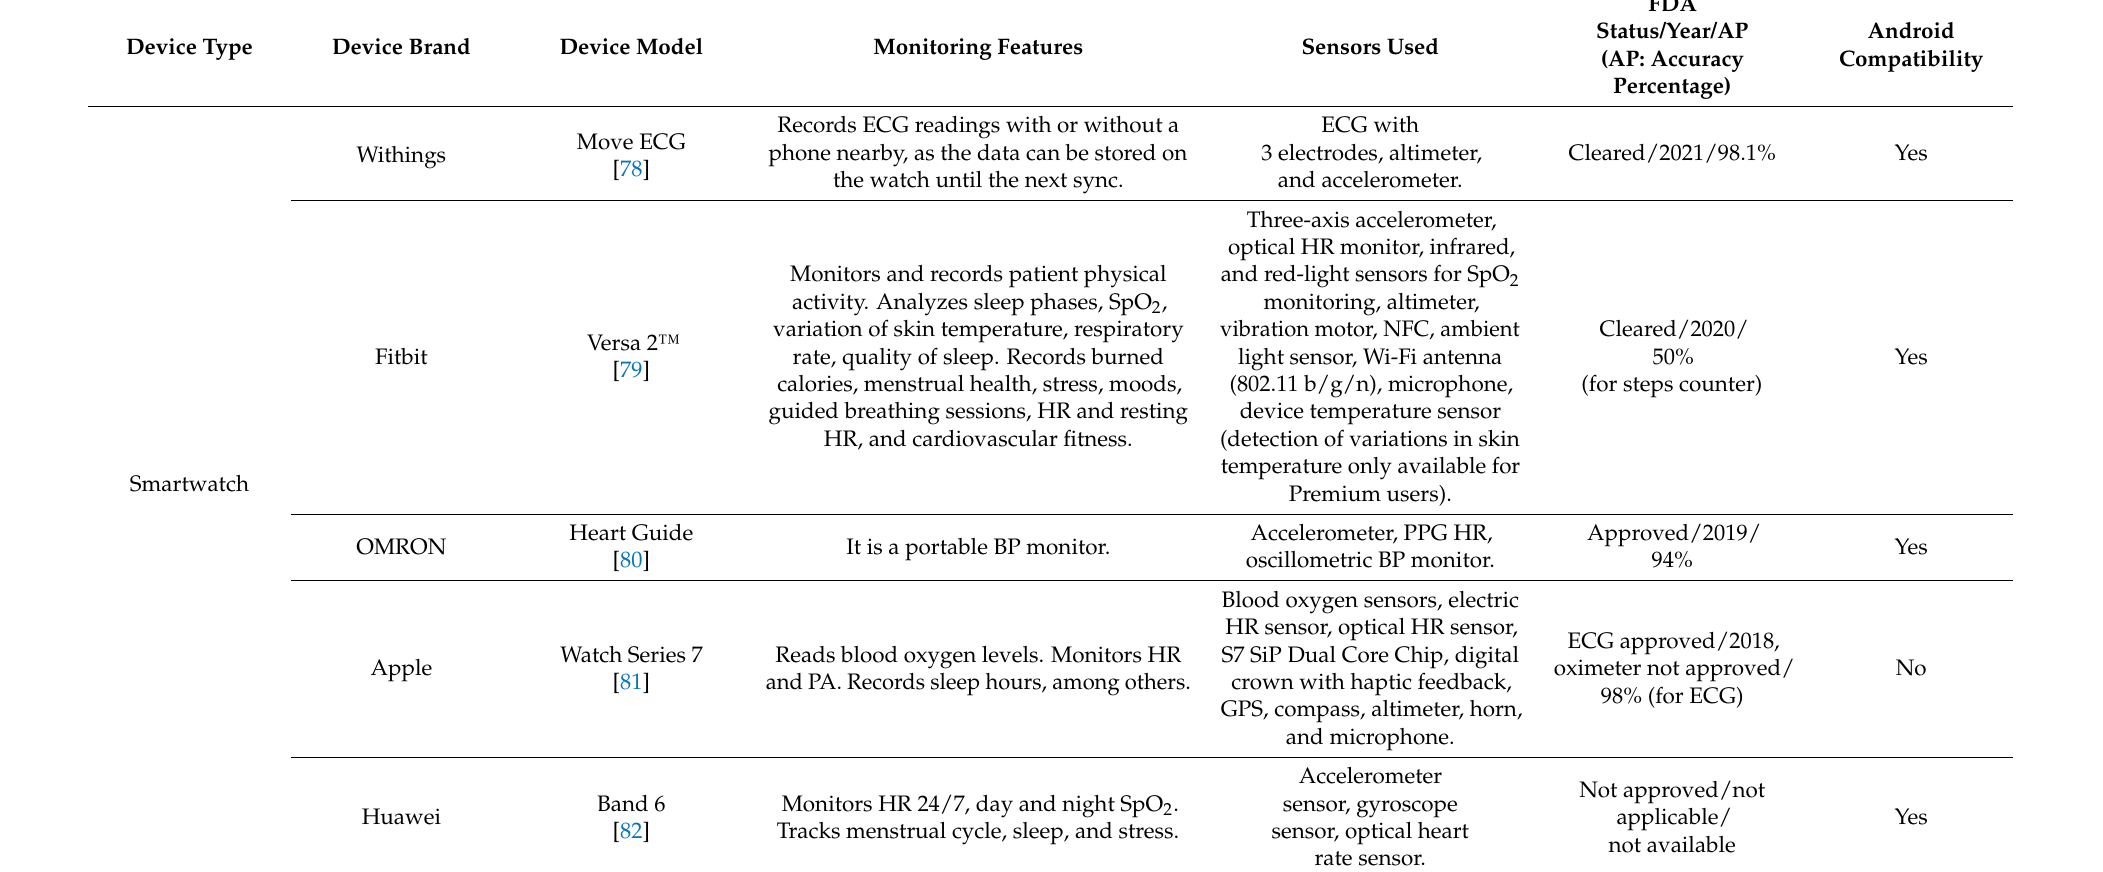
Table 1. Commercial Wearable Devices for CVD